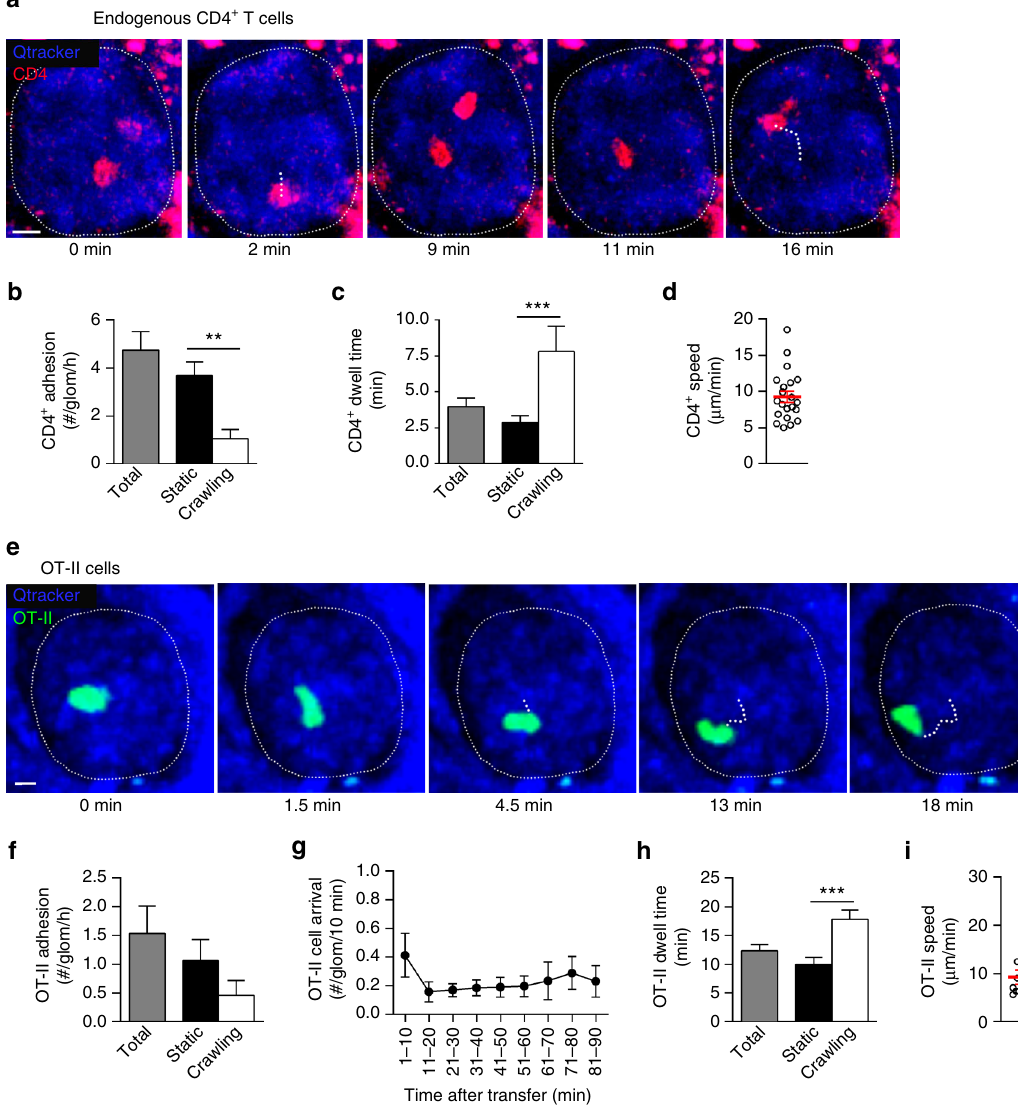
Fig. 1 CD4 + T cells migrate constitutively in the unin fl amed glomerular microvasculature. a – d Retention and migration of endogenous CD4 + T cells in the glomerular microvasculature of untreated mice, as assessed using multiphoton intravital microscopy. a Image sequence showing CD4 + T cells (anti-CD4- PE, red) undergoing retention and migration in the glomerular capillaries (vasculature detected via Qtracker ® 655 — blue). The glomerular border is denoted by a thin dotted line, and the migration paths of two CD4 + T cells are indicated by thick dotted lines (time elapsed shown below images). See also Supplementary Movie 1. Scale bar, 10 μ m. b – d Quanti fi cation of adhesion and migration of endogenous CD4 + T cells in glomeruli of untreated mice ( n = 6 mice). Data show number ( b ) and dwell time ( c ) of adherent CD4 + T cells, and velocity of crawling cells ( d ). In b and c , data are shown for total cells, and speci fi cally for static or crawling cells. In b , data are expressed as # per glomerulus per h per mouse. In c , data are expressed per cell ( n = 124 total, 96 static and 28 crawling). In d , circles represent individual cells ( n = 21). e – i Retention and migration of effector CD4 + T cells in the glomerular microvasculature of untreated mice. OT-II cells were activated in vitro, labeled with CFSE (green) and transferred into unin fl amed mice. e Image sequence showing effector CD4 + T cell (green) migrating within the glomerular capillaries. See also Supplementary Movie 2. Scale bar, 10 μ m. f – i Quanti fi cation of adhesion and migration of activated OT-II cells in glomeruli in the 90 min following transfer ( n = 8 mice). f Number of adherent cells, shown for total, static, and crawling cells, expressed as OT-II cells per glomerulus per h per mouse. g Rate of OT-II cell adhesion, assessed in 10 min intervals. h Dwell time of total, static, and crawling OT-II cells ( n = 333 total, 232 static and 101 crawling). i Migration speed of crawling OT-II cells. In i , circles represent individual cells ( n = 16). In b – d and f – i , data are shown as mean ± s.e.m. (as red lines in d and i ). ** P < 0.01; *** P < 0.001. b , c , f and h : unpaired Student ’ s t glomeruli were imaged for 2 h after OT-II transfer. Compared to described in other organs 31,32,34 . To identify when the increased control mice receiving unconjugated 8D1 mAb, more OT-II cells retention of crawling OT-II cells occurred, the rate of OT-II cell adhered in glomerular capillaries of mice receiving 8D1/pOVA recruitment to the glomerular capillaries was examined in 10 min (Fig. 2a), due solely to an increase in the number of crawling cells intervals during the 2 h after transfer. In mice given 8D1/pOVA, a (Fig. 2b). OT-II cells also crawled more slowly in mice that signi fi cant increase in crawling OT-II cells was detectable 71 – 80 received 8D1/pOVA (Fig. 2c), a fi nding consistent with the min after transfer (Fig. 2d). In contrast, the rate of arrest of static reduced velocity of effector T cells during antigen recognition OT-II cells was constant after the fi rst 20 min of the observation